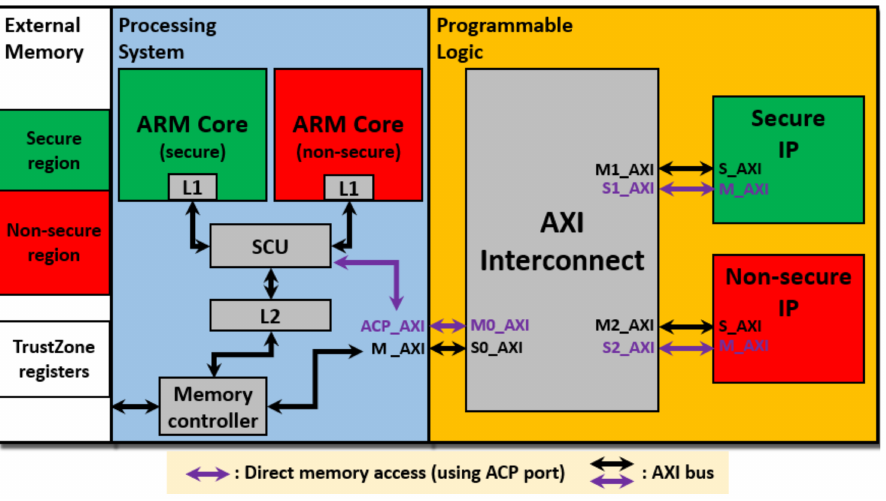
Figure 4. Experimental design (secure memory region/core/IP are in green, non-secure in red) im-plemented in a Xilinx Zynq